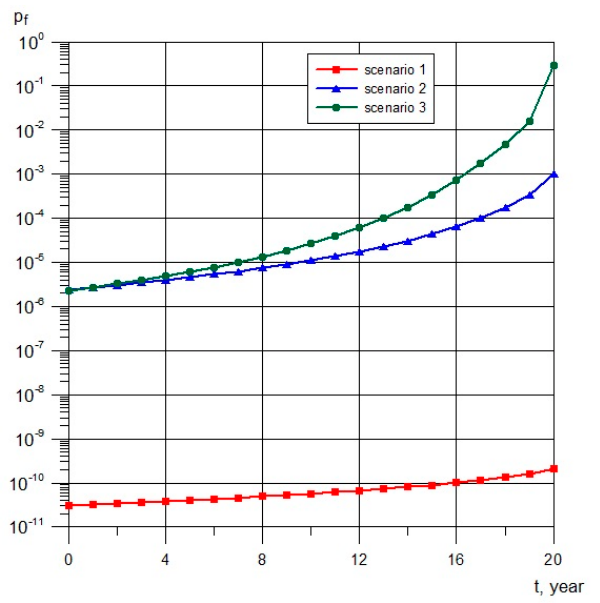
Figure 7. Change in the probability of rotor failure for di ff erent operating scenarios ( a 0 = 2 mm).